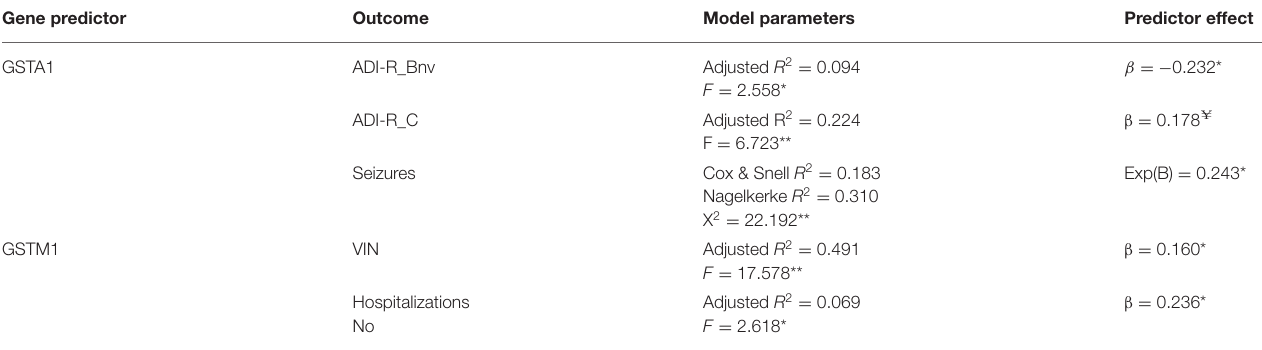
TABLE 3 | Multiple linear or logictis regression predictor effects of genotype on clinical outcomes (controlling for other genotypes and age).